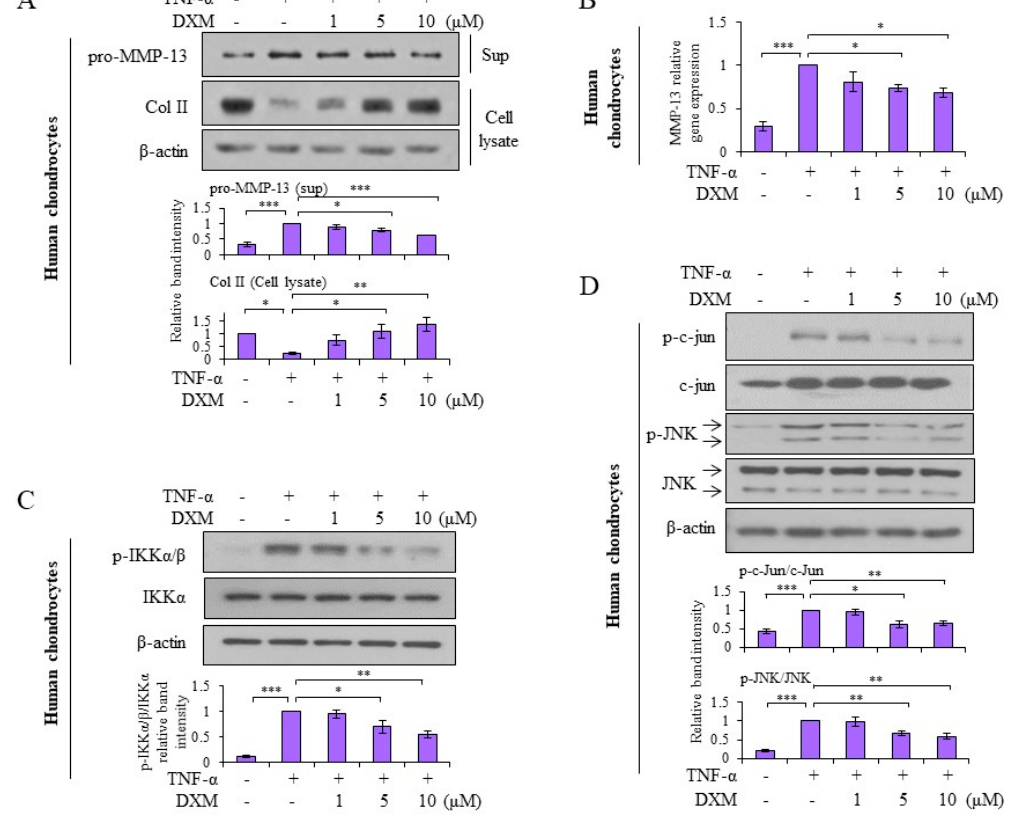
Figure 5. Mechanisms and chondro-protective effects of DXM were verified in human OA chondrocytes. ( A ) Human OA chondrocytes were co-treated with TNF- α (5 ng/mL) and various doses of DXM for 24 h. Total cell lysate and supernatants were analyzed for pro-MMP-13 and Col II expression with Western blots. ( B ) Chondrocytes were treated with TNF- α (5 ng/mL) and various doses of DXM for 8 h. The mRNA levels of MMP-13 were determined by real-time RT-PCR. ( C ) Chondrocytes were pretreated with various doses of DXM for 2 h, and then the cells were stimulated with TNF- α for 15 min. Total cell lysates were analyzed with Western blots (for pIKK α / β , IKK α and β -actin expression). ( D ) In parallel, the expression of p-c-Jun, c-Jun, p-JNK, and JNK (c-Jun N-terminal kinase) in total cell lysates was determined. Data were shown as representative data from at least three independent experiments of different donors. Values are the means ± S.E.M. and significance (* p < 0.05; ** p < 0.01; *** p < 0.001) was analyzed by one-way ANOVA.